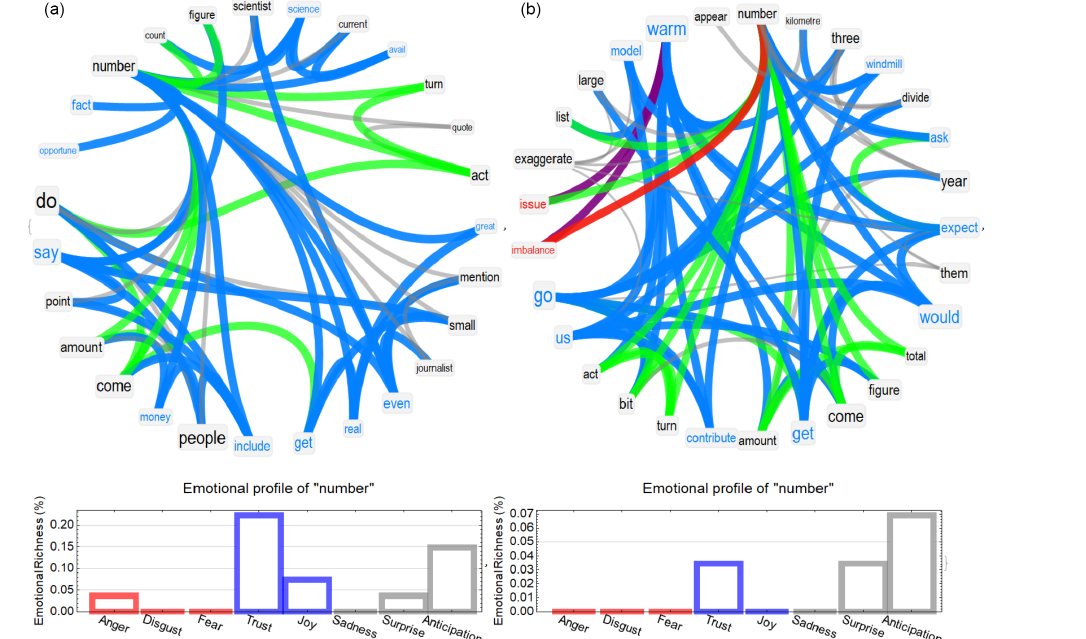
Figure A11. Speakers’ mindset reconstruction around “number” in the speeches of Greta Thunberg (a) and Christopher Monckton (b) . We refer the reader to Fig. 1 for a detailed explanation of the colour code and to Lexicon 1 for an interpretation of the figure.